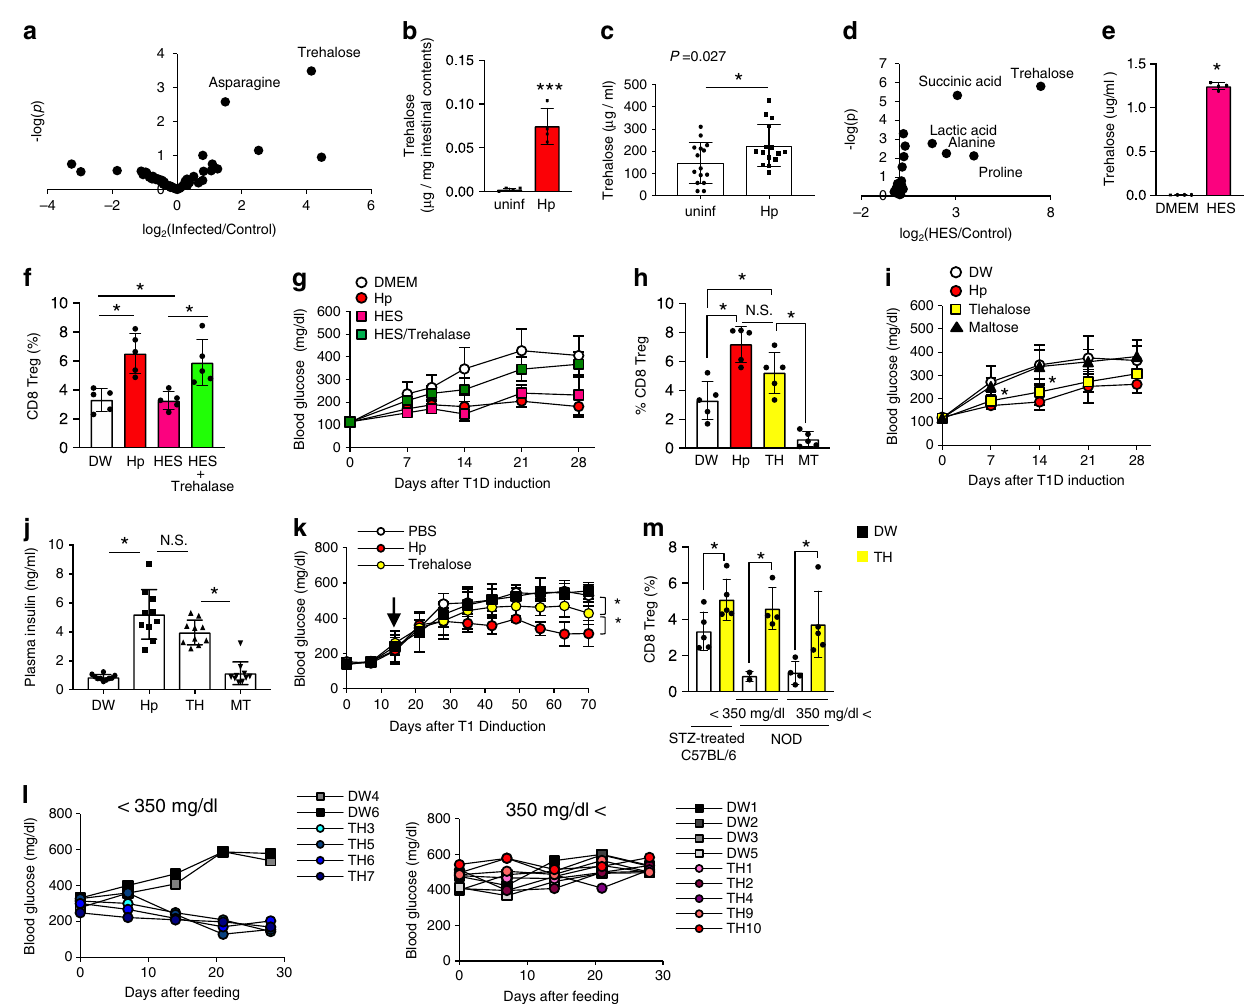
Fig. 2 Trehalose derived from Hp induces CD8 + Treg cells. a Forty-eight metabolites identi fi ed in the contents of the small intestines of fi ve uninfected and four Hp-infected mice ( a ), and 33 metabolites in DMEM used to culture adult worms [Hp excretory/secretory (HES) antigens] ( d ) using GC/MS were subjected to univalent analyses, and volcano plots are shown. Trehalose in the small intestines of b and trehalose concentrations among HES antigens ( e ) were measured by GC/MS. c Trehalose concentrations in serum from the indicated mice were measured using ELISA. f Splenic CD8 + Treg cells in mice orally administered HES antigens or HES antigens exposed to trehalase and mice infected with Hp were analysed as described in Fig. 1d, and the frequency is shown. g Blood glucose concentrations were monitored in these mice after T1D induction. h – j Mice fed trehalose (TH) and maltose (MT) as a control disaccharide were subjected to T1D induction. Hp-infected (Hp) and uninfected (DW) mice were used as positive and negative controls, respectively. Splenic CD8 + Treg cells were quanti fi ed 2 weeks after feeding as described in Fig. 1d, and the percentages of these cells are shown ( h ). Blood glucose ( i ) and plasma insulin levels ( j ) were analysed as described in Fig. 1a, b. k Female NOD mice were fed with TH after hyperglycaemic onset. l Glucose levels of individual mice with hyperglycaemia of <350 mg/dl ( left panel ) or more than 350 mg/dl ( right panel ) at the beginning of sugar feeding. m Splenic CD8 + Treg cells in NOD mice used in l were quanti fi ed at 2 weeks after feeding trehalose as described in Fig. 1d, and the percentages of these cells are shown. Values represent the mean ± S.D. of 10 mice except for fi ve mice in b . Asterisks denote statistical signi fi cance at p < 0.05 calculated by the two-tailed Mann – Whitney test ( b , e ), two-sided unpaired Student ’ s t -test ( c ), t wo-way ANOVA ( g , i , k ) and Tukey post-hoc analysis ( f , h , i , m ). NS indicates not signi fi cant. All experiments except for GC/MS run ( a ) and NOD mice ( m , l ) each once, were repeated at least three times with similar Absolute quanti fi cation of trehalose in the intestinal contents was analysis of Hp excretory/secretory (HES) antigens collected from also performed using GC/MS. Identi fi cation of trehalose in bio- culture supernatants of adult worms revealed that the trehalose logical samples by GC/MS is dif fi cult because of its similarity to level was highly elevated among HES antigens (Fig. 2d, e). Three both the mass spectrum and retention time of methoximated metabolites including trehalose were signi fi cantly increased maltose, a disaccharide consisting of two glucose molecules. Thus, among HES antigens (Supplementary Table 2), indicating that Hp trehalose and maltose with methoximation were analysed in produced and secreted trehalose in the intestines. In addition to detail and differentiated clearly (Supplementary Figs. 5, 6). adult worms, infective L3 larvae secrete trehalose. Fourier trans- Finally, a substantial amount of trehalose was observed in the form infra-red (FTIR) microscopic analyses revealed the location intestinal contents of Hp-infected mice (Fig. 2b). The trehalose of concentrated trehalose as vesicle-like red signals along the concentration in the serum of mice infected with Hp was sig- worm body surface. Thus, a large amount of trehalose was ni fi cantly higher than that in uninfected mice (Fig. 2c), suggesting detected in the preservative water containing L3 larvae (Supple- that trehalose is absorbed from the intestines. Furthermore, mentary Fig. 7a, b).